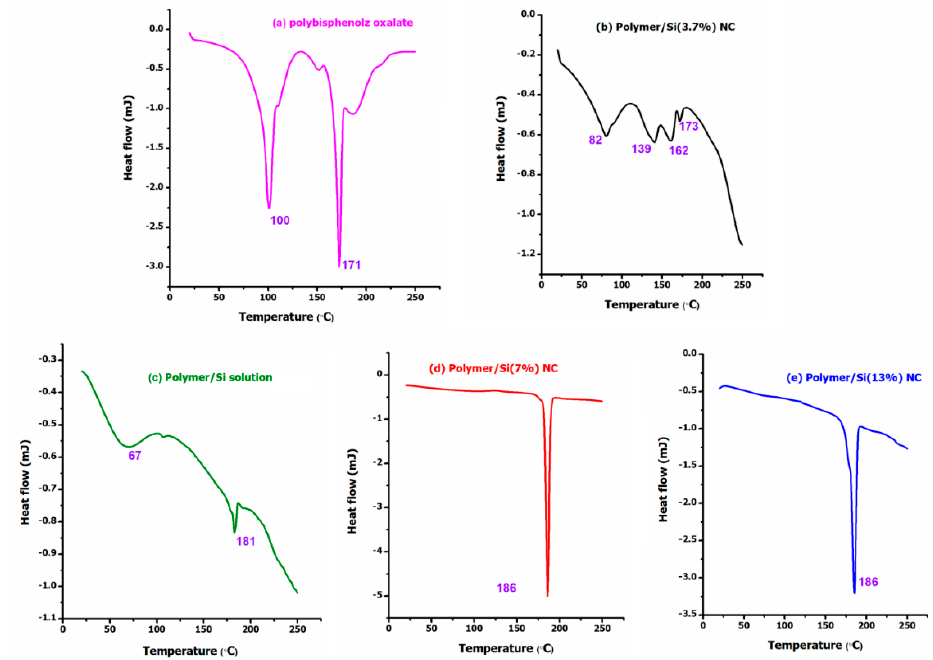
Figure 3. Comparison of the DSC thermograms of poly(4,4’-cyclohexylidene bisphenol oxalate) and poly(4,4’-cyclohexylidene bisphenol oxalate/Si NCs: ( a ) Pure poly(4,4’-cyclohexylidene bisphenol oxalate); ( b ) poly(4,4’-cyclohexylidene bisphenol oxalate)/Si(3.7%) NC; ( c ) poly(4,4’-cyclohexylidene bisphenol oxalate)/Si solution,); ( d ) poly(4,4’-cyclohexylidene bisphenol oxalate)/Si(7%) NC; and ( e ) poly(4,4’-cyclohexylidene bisphenol oxalate)/Si(13%) NC.